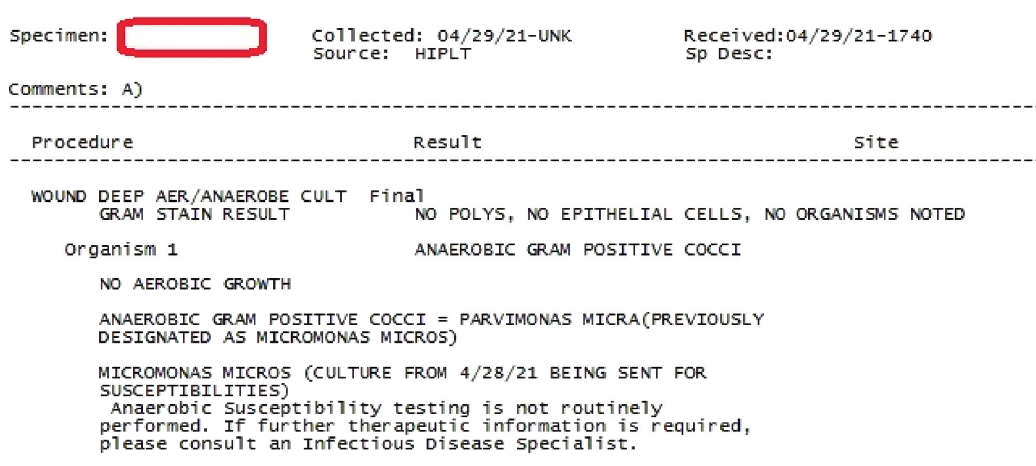
Figure 3: Details of intraoperative culture